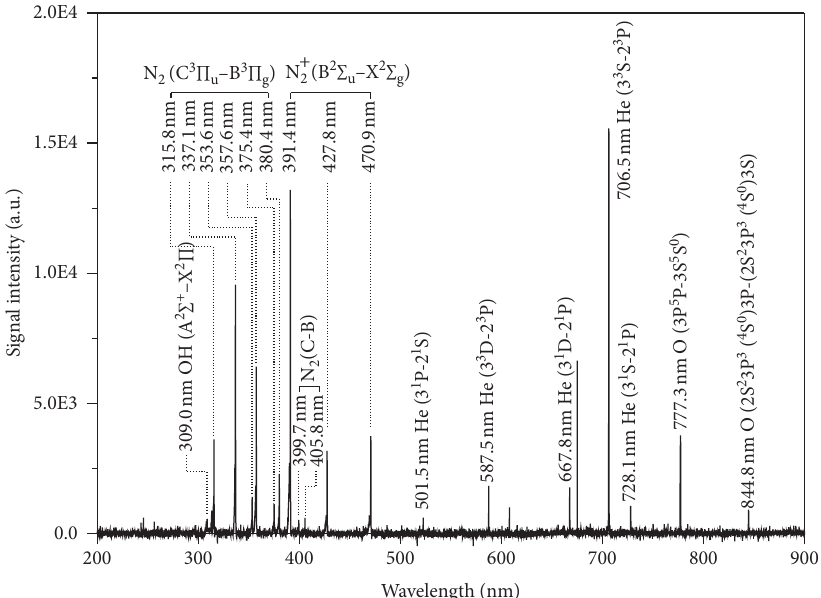
Figure 10: Optical emission spectra of the He-plasma